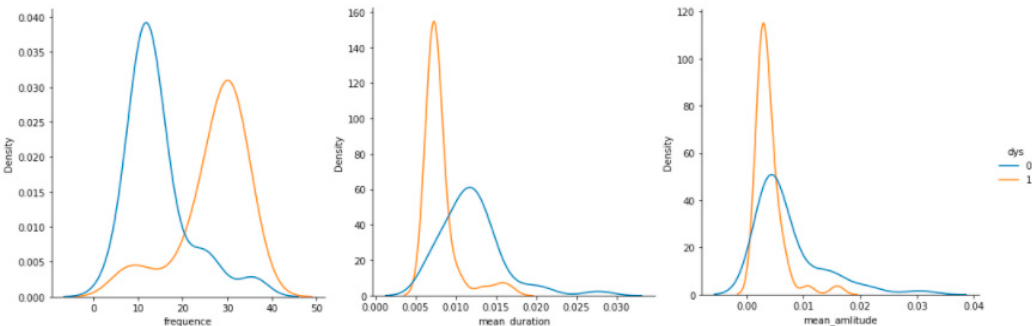
Figure A8. Distribution of the DGI for the painting 4 dataset.